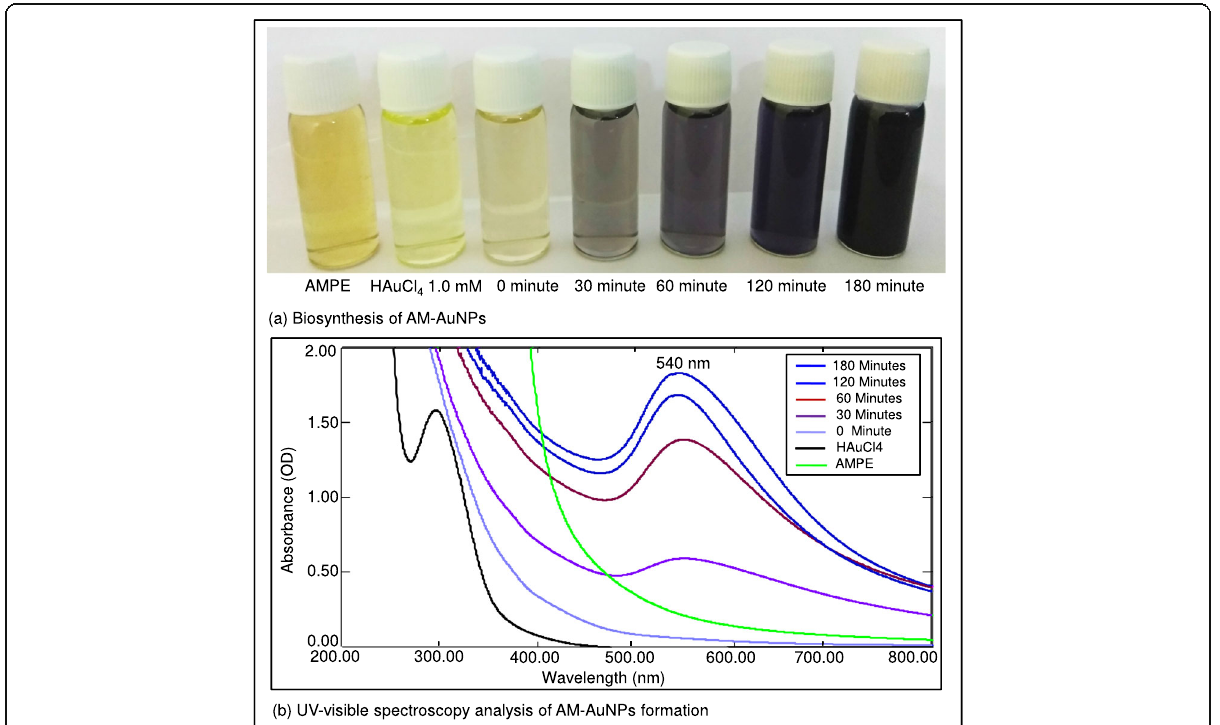
Fig. 1 a Biosynthesis of gold nanoparticles indicating transformation of color of reaction mixture containing A. mexicana plant extract and 1 mM HAuCl4·3H2O solution at various time periods (0 – 180 min). b Time-dependent UV-visible spectrometry analysis of AM-AuNPs formation showing spectra of A . mexicana plant extract, HAuCl4·3H2O, and AM-AuNPs. The absorption spectrum of biosynthesized AuNPs exhibited a strong peak at 540